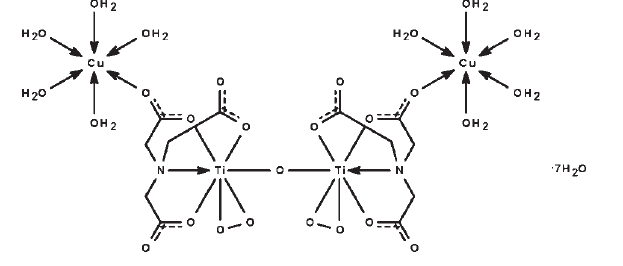
the hydrated sodium and ammonium salts of oxobis(nitrilotriacetatoperoxotitanates), see: Schwarzenbach & Girgis (1975); Zhou et al. (2004).